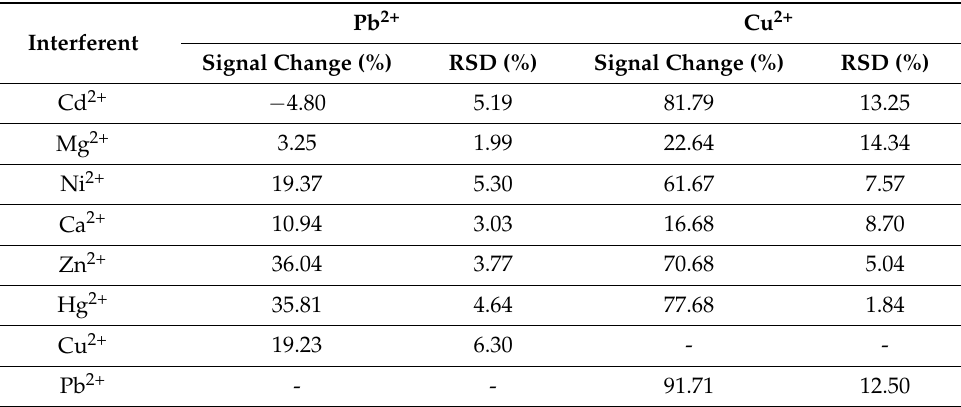
Table 2. Current response of the TC4/AuNPs/SPCE sensor in the detection of 1.0 ppm Pb 2+ and Cu 2+ with the presence of different interferent ions at the same concentration (1.0 ppm) in 0.1 M, pH